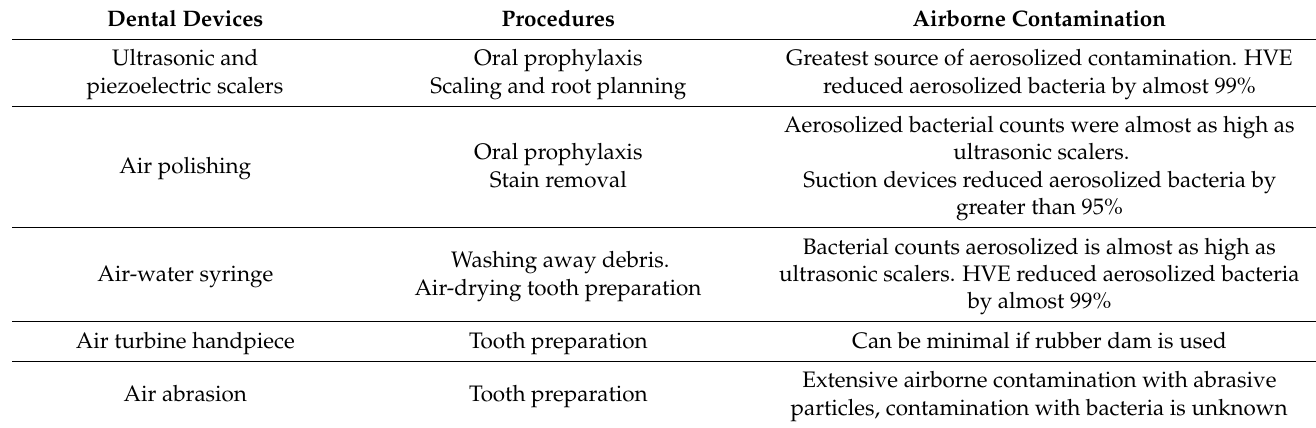
Table 2. Dental devices and procedures that produce airborne